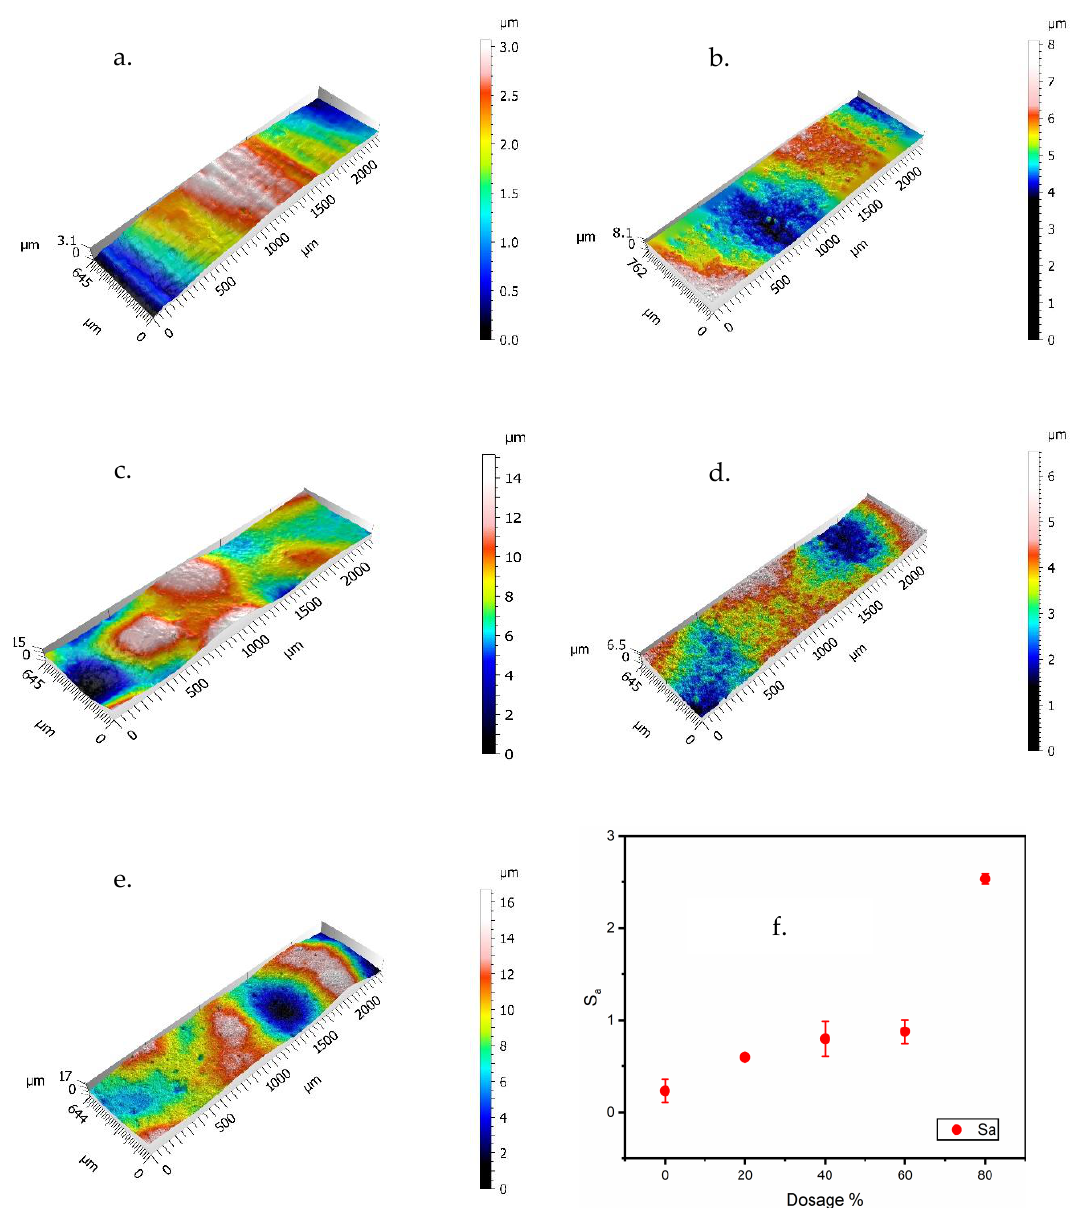
Figure 4. ( a–e ) Confocal maps and ( f ) surface roughness (S a ) values of the coating surfaces. ( a ) Control-PC; ( b ) Zn–20%-PC; ( c ) Zn–40%-PC; ( d ) Zn–60%-PC; ( e ) Zn–80%-PC; ( f ) S a values. As the handheld film thickness gauge probe had a sizeable near-flat tip area (diameter ≈ 12 mm), the measured thickness was the distance from the substrate to the multiple asperity peaks on the coating surface. For the same measured film thickness, coating films with a higher zinc content had a higher surface roughness and therefore a lower true film thickness, i.e., less coating material was deposited onto the substrate. The effect of this difference on the protective performance of the coatings was investigated. The surface quality, as represented by the specular gloss at 60 ◦ , DOI (distinctness- of-image), and reflection haze values, is plotted in Figure 5a. The gloss and DOI values decreased with increasing zinc dosage, showing the same trend as the surface roughness value S a .